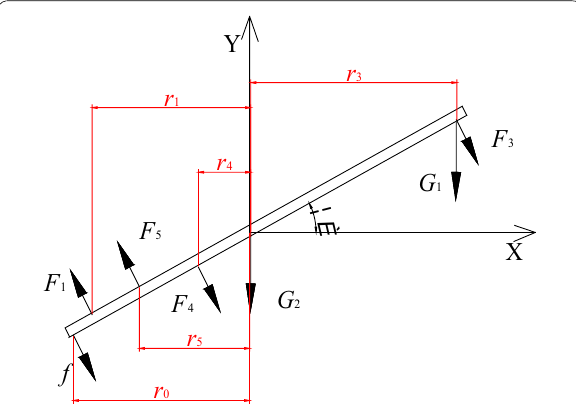
Figure 7 Force analysis of the proposed piston rod with a reactive force structure